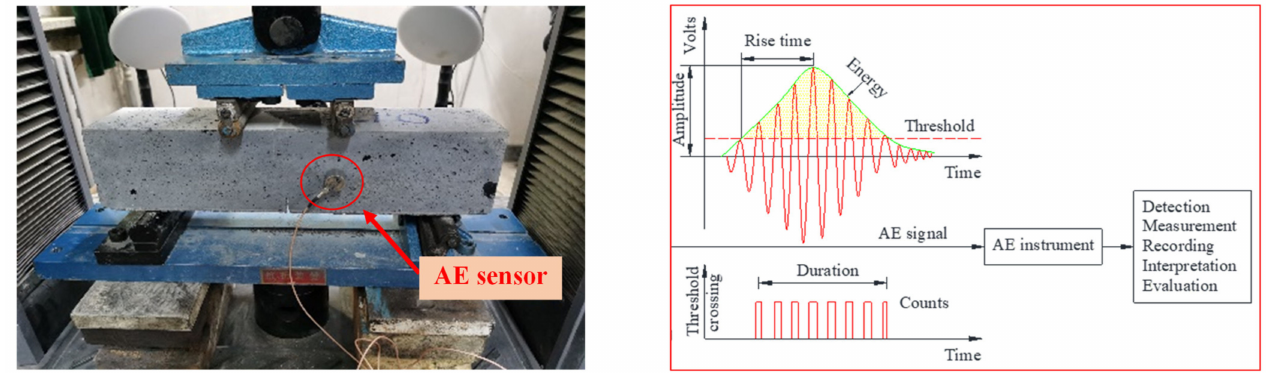
Figure 1. AE tests of UHPC notched beams under four-point bending and corresponding AE